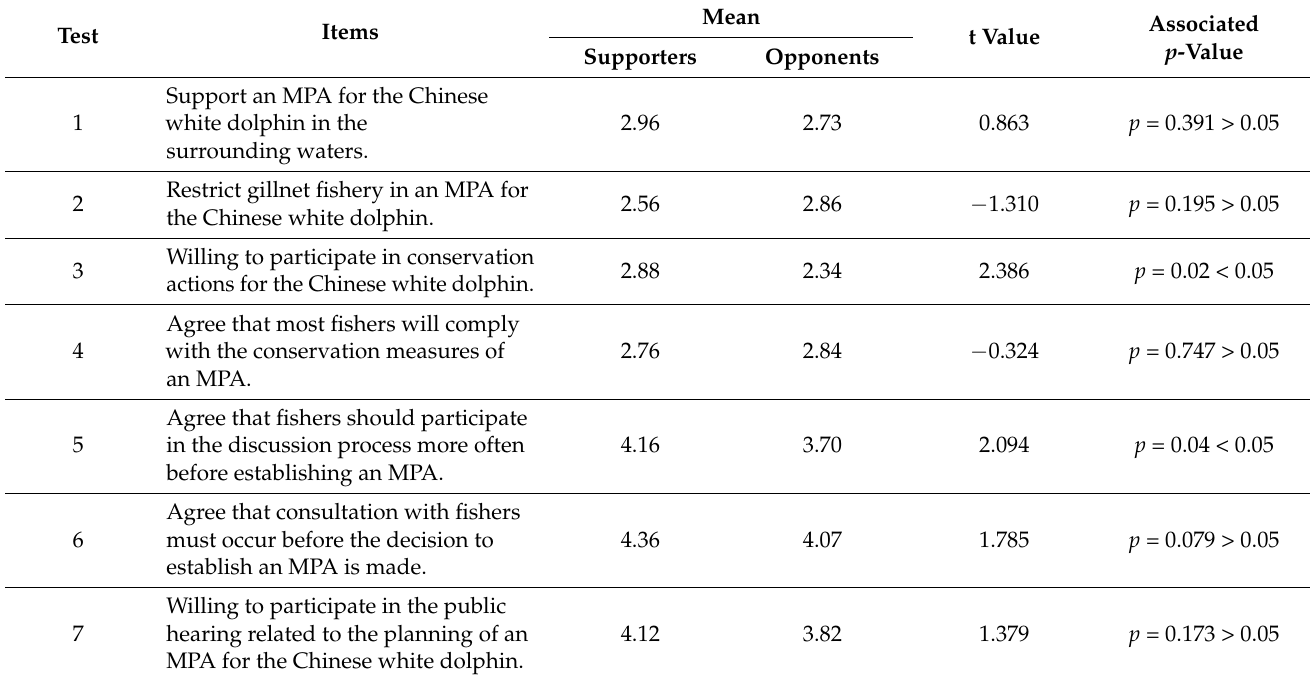
Table 6. Statistical testing on fishers’ opinions regarding the conservation of the Chinese white dolphin ( n =